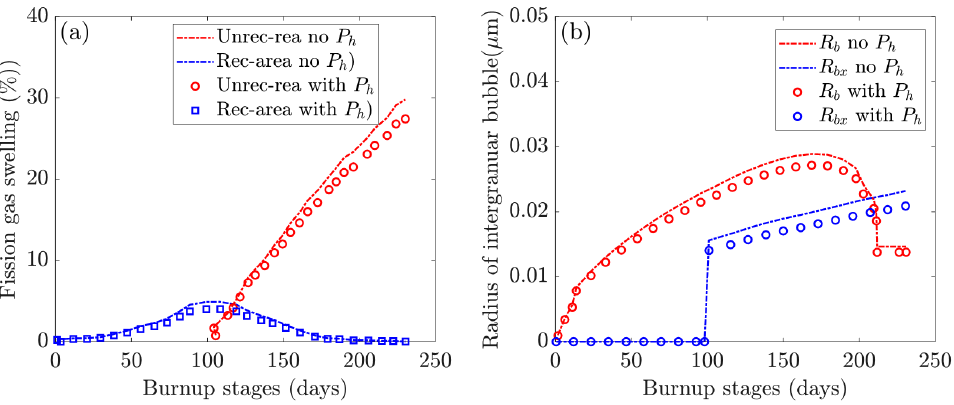
Figure 4. Investigations of multiscale fission swelling behavior in different simulation scenarios: ( a ) fission gas swelling in the non-recrystallized and recrystallized regions; ( b ) intergranular bubble radius in the non-recrystallized ( R b ) and recrystallized ( R bx ) regions.